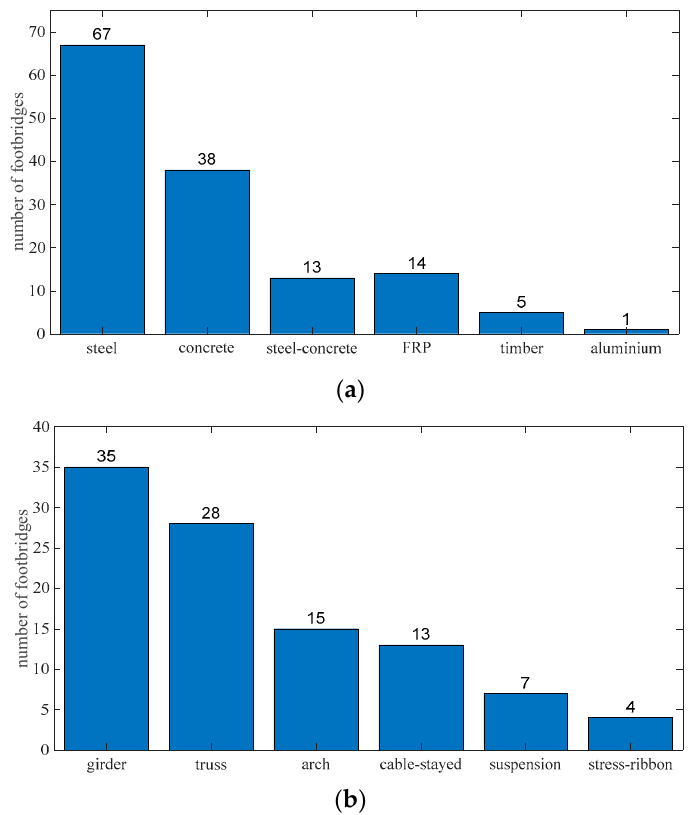
Figure 2. Number of footbridges. ( a ) Construction materials; ( b ) bridge types.